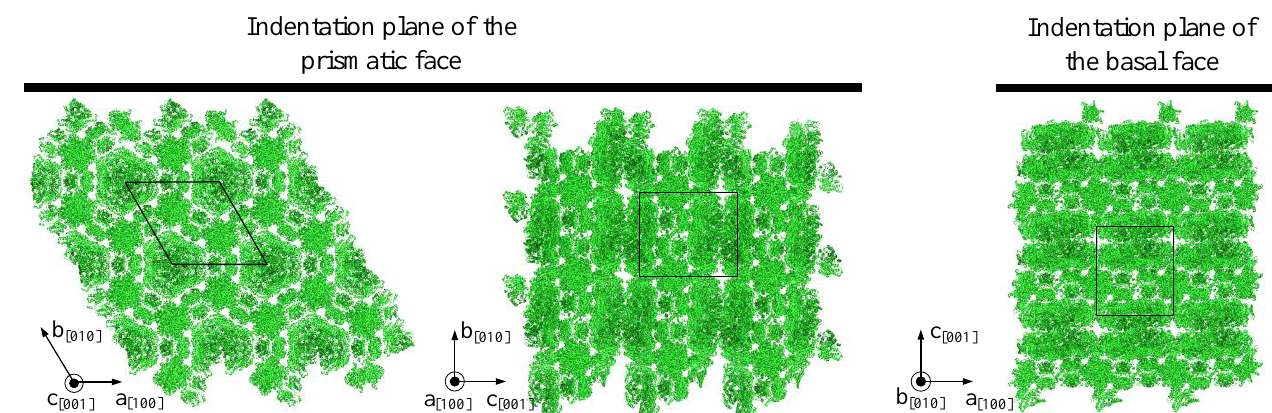
Figure 10. Molecular packing of HheG crystals with marked boundaries of the unit cell. The black line shows a trace of the prismatic (left ) and basal ( right ) face on which indentation was performed. The indices a, b, and c refer to the three edges of the unit cell and the corresponding IJK indicies.